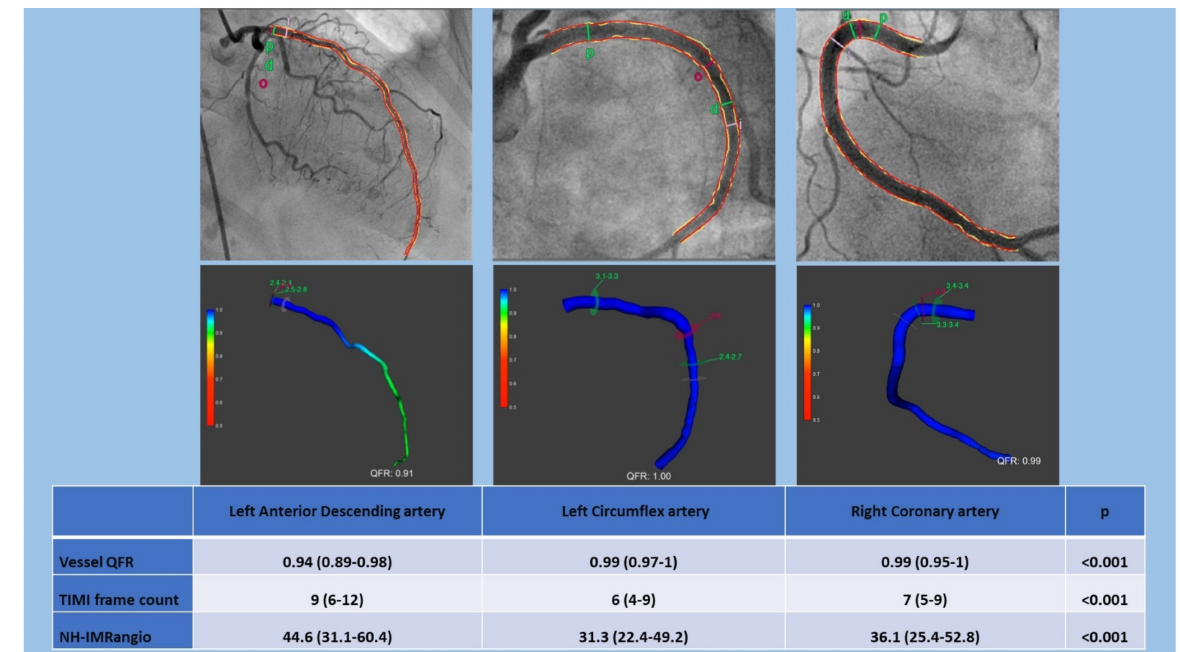
Figure 2. Hemodynamic measurements in patients with Takotsubo syndrome (TTS). QFR: quantitative flow ratio; NH- IMRangio: non-hyperaemic angiography-derived index of microcirculatory resistance.